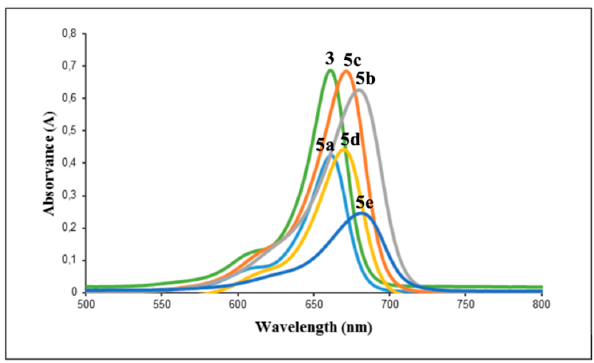
Figure 1. Absorption spectra of unsubstituted squaraine 3 and aminosquaraines 5a – e in MeOH/CH 2 Cl 2 , 99/1 ( v / v ). Table 1. Visible spectral data and fluorescence and singlet oxygen generation quantum yields of squaraine dyes 3 and 5a – e .